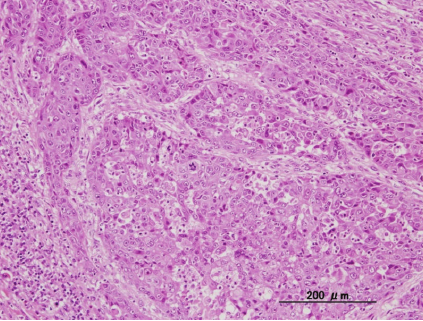
Figure 5: Pathological findings for high-grade malignancy. A large number of strongly heteromorphic, solid foci are apparent.